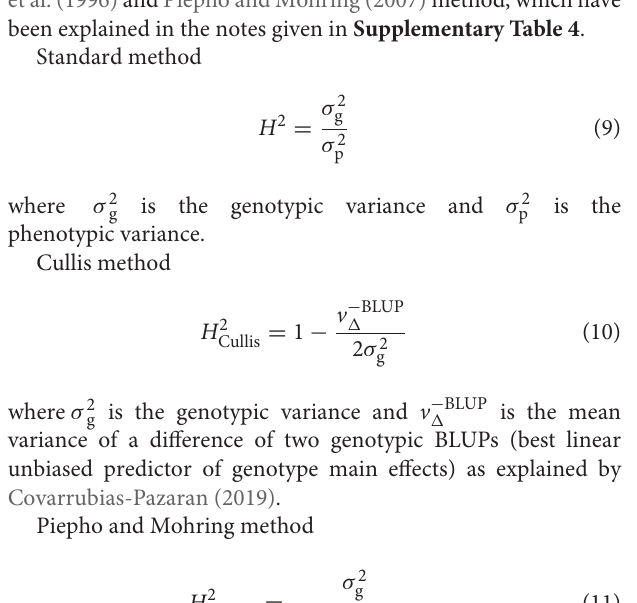
TABLE 1 | Validation parameters for different machine learning algorithm-based prediction models employed for predicting fresh biomass. Min. 1st Qu. Median Mean 3rd Qu.